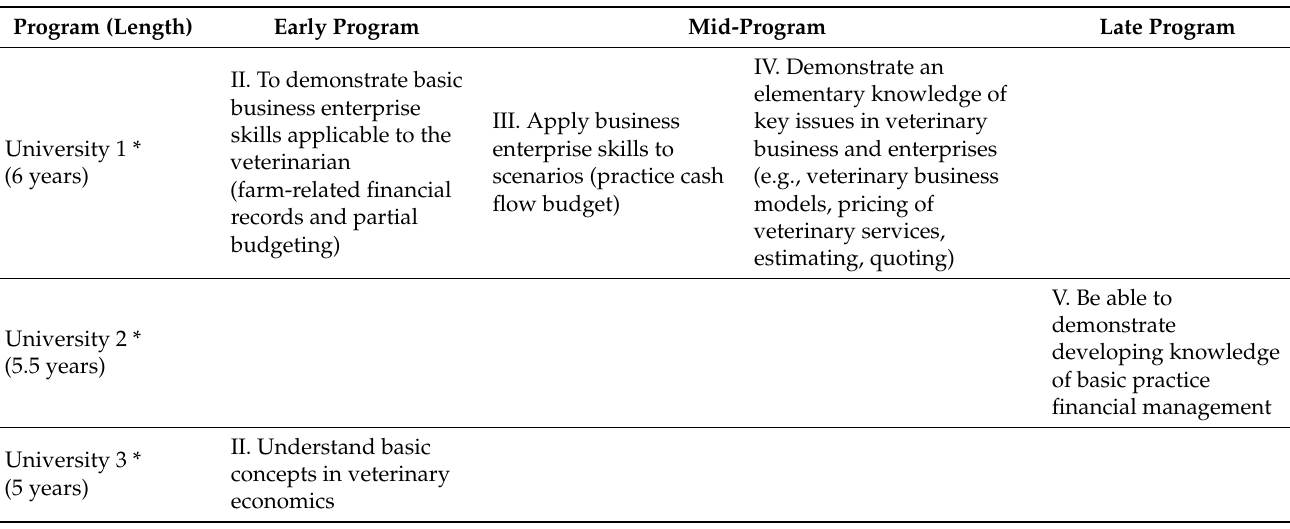
Figure 2. Mean scores (with standard errors) of entrepreneurial intention (EI), corporate work intention (CWI), entrepreneurial self-efficacy (ESE) (Pre-Venture, People and Finances dimensions), and outcome expectations of starting a business (OE-start-business), of respondents in the three participating veterinary schools (n = 236). Significant difference of respondents of University 1 to the other two veterinary schools (* p < 0.05, ** p < 0.01, *** p < 0.001) 1 University 1, 2 University 2, 3 University 3. Table 6. Curricula content relevant to understanding of the business of veterinary practice for Mean score comparison using the ANOVA procedure showed no between ‐ group veterinary respondents of this study per veterinary program (university) per year main effect for CWI. ( F (2,233) = 0.669, p = 0.513). Between ‐ group effects were found for EI